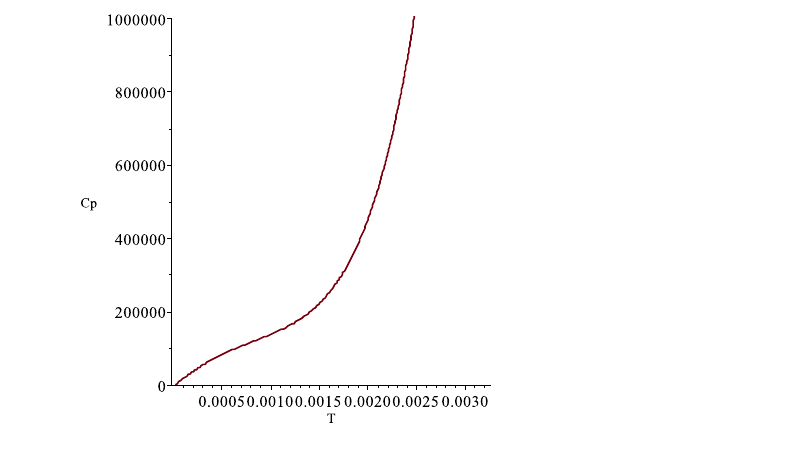
Figure 4 . Speci(cid:12)c heat. This curve represents C P , the speci(cid:12)c heat of the system, as a function of the temperature. It is plotted for P = (cid:0) 0 : 0001 and (cid:8) = 0 : 1.